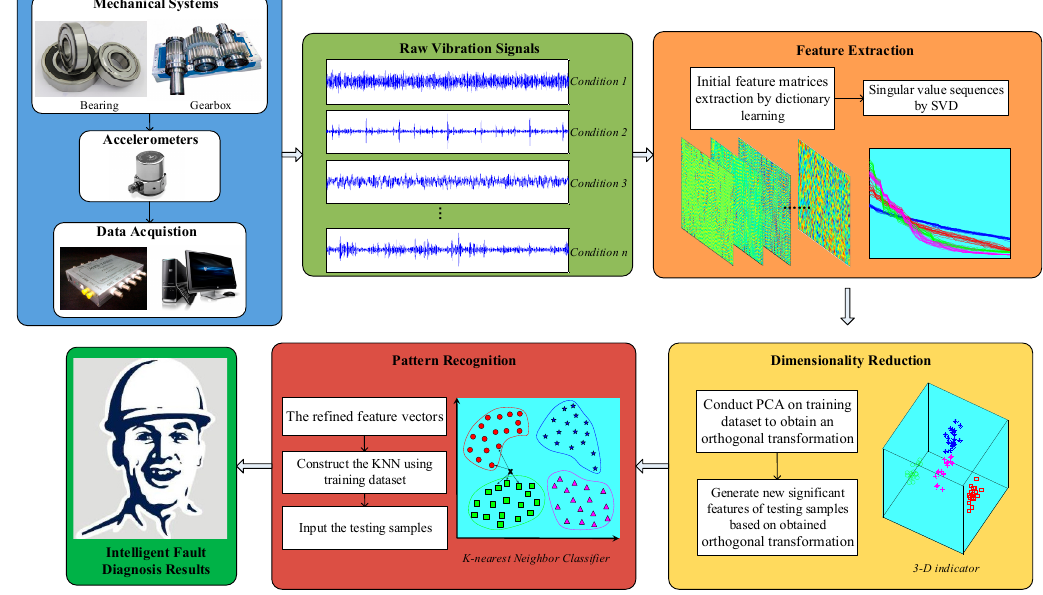
Figure 3. Block diagram of the overview of the proposed approach.